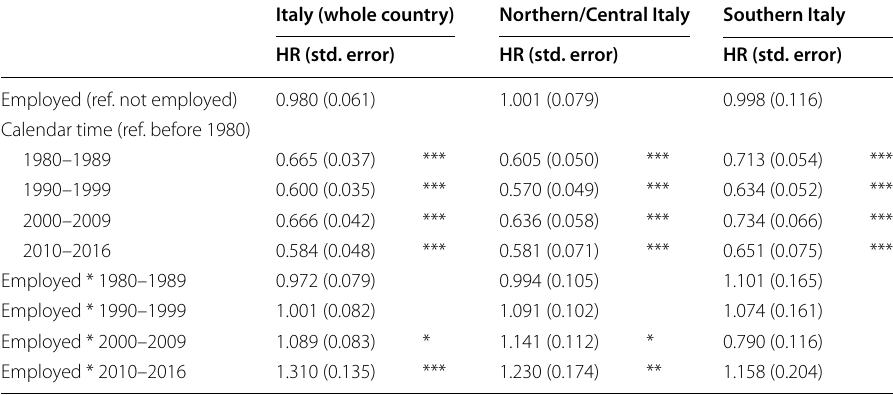
Models control for parents’ education, place of birth, ever migrated, respondent’s education, union